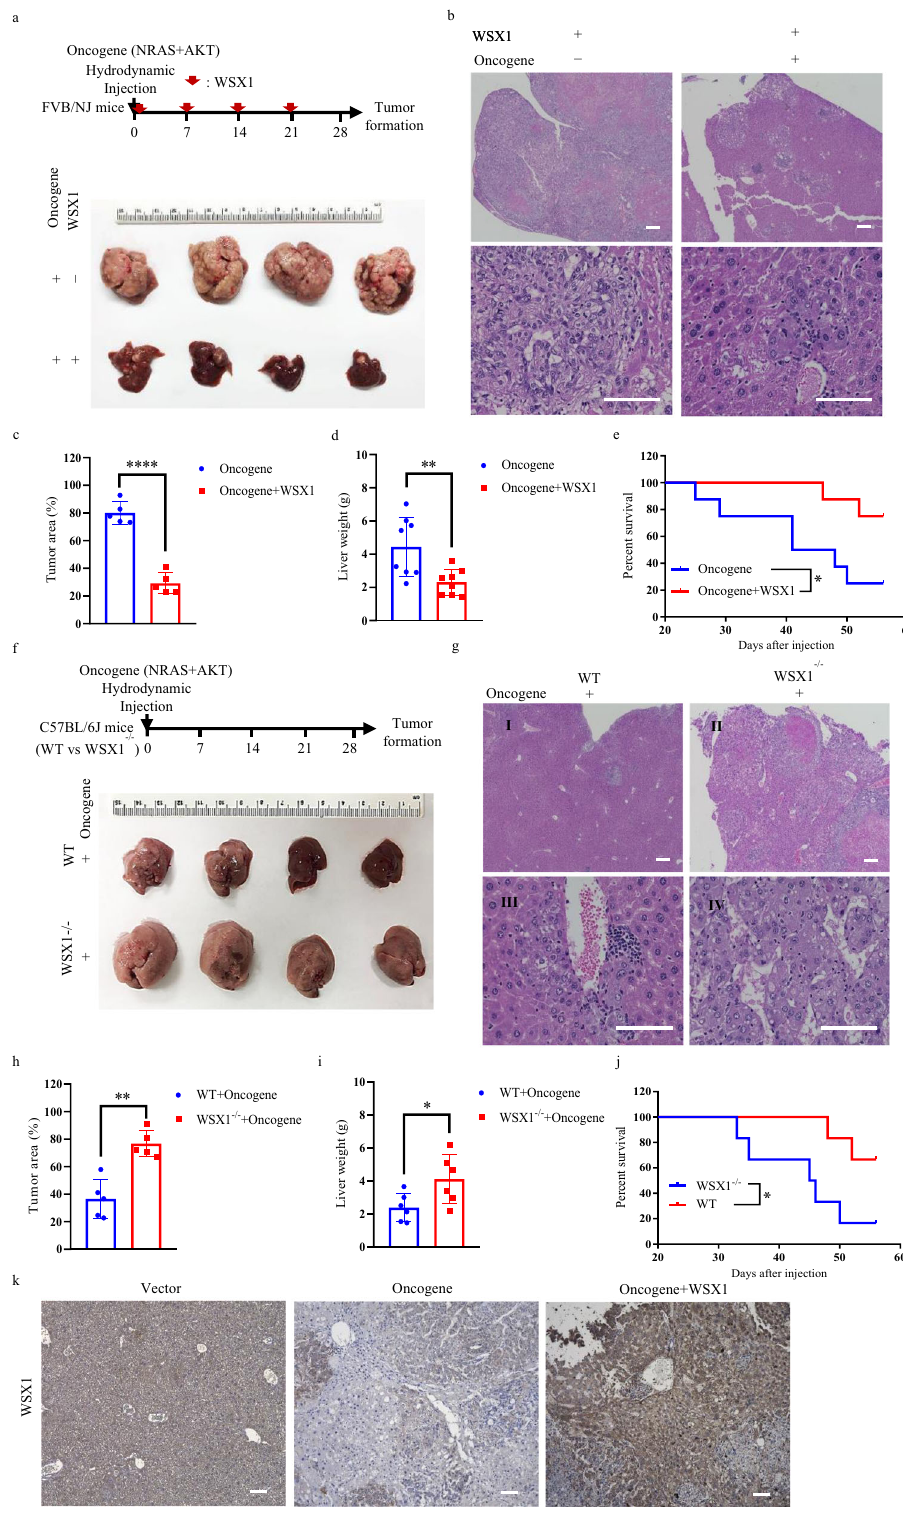
were much more susceptible to NRAS/AKT -induced oncogenesis (Fig. 2f). Speci fi cally, compared with wild-type mice, WSX1 − / − mice showed earlier tumor formation, more neoplastic lesions ( P = 0.0012, Fig. 2g, h), increased liver weight ( P = 0.0328, Fig. 2i), and signi fi cantly poorer survival (HR = 4.821, P = 0.0252, Fig. 2j). Together, these results further supported the tumor-suppressive role of WSX1 in HCC development. no signi fi cant in fl uence on the tumor-suppressive effect of